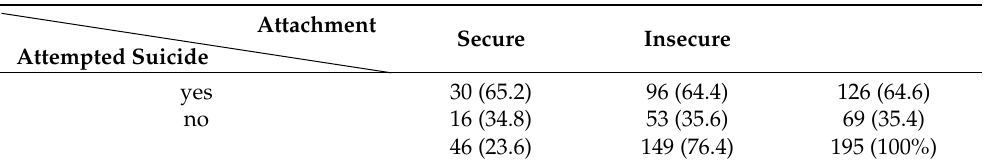
Table 5. Patients admitted to the psychiatric secure unit according to security of attachment to mother and lifetime experience of attempting suicide. Data are number of patients (%).